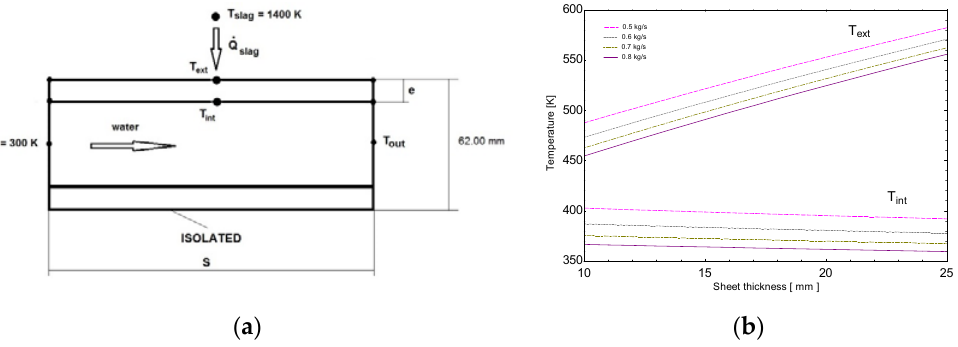
Figure 9. ( a ) Simplified heat transfer model; ( b ) temperature output.